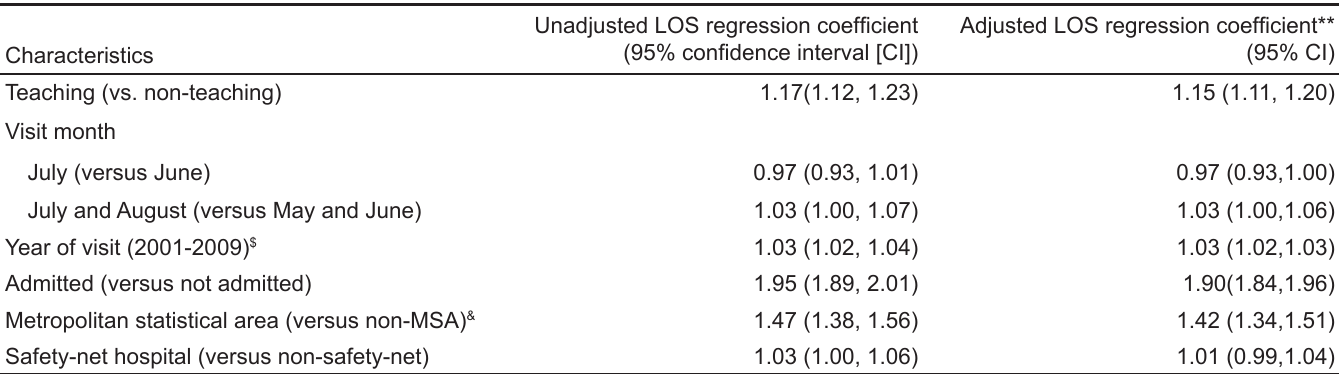
Table 2: Factors associated with length of stay (LOS)*, 2001-2009.